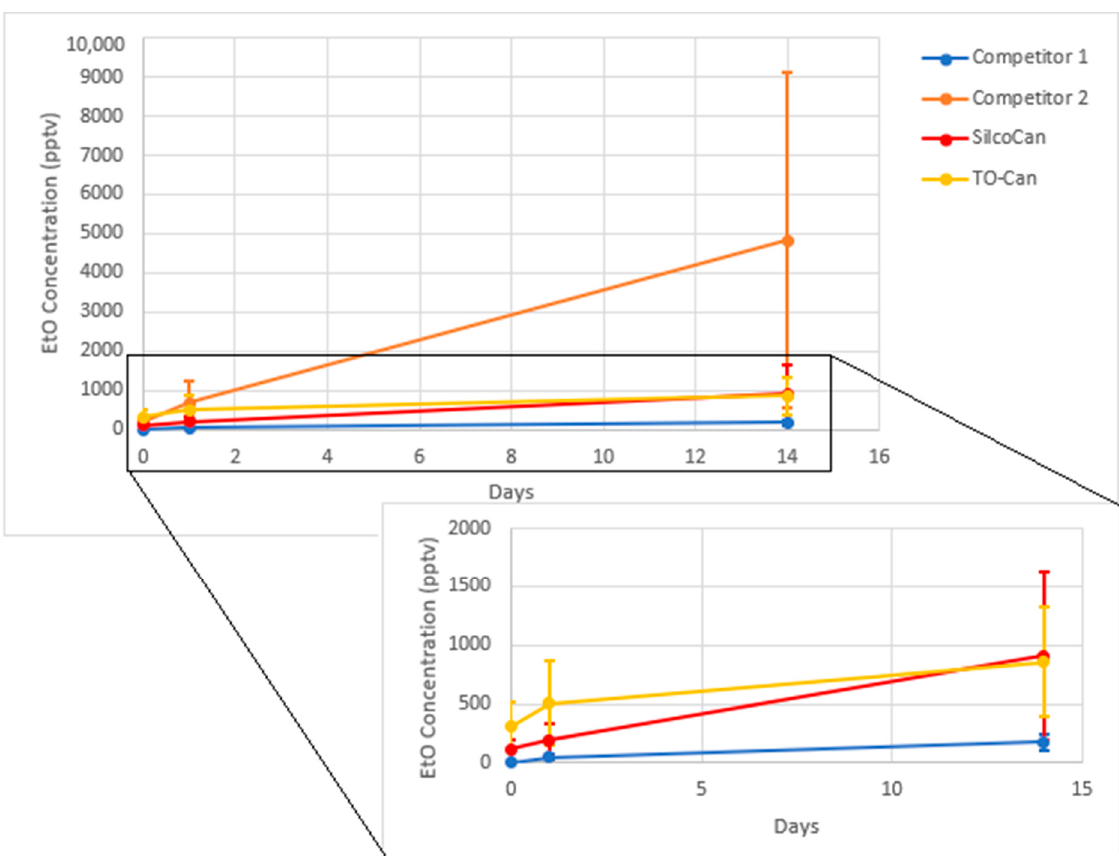
Figure 6. Ethylene Oxide growth over time. Average of 3 canisters for each data point, error bars are 1 standard deviation. Insert excludes Competitor 2.